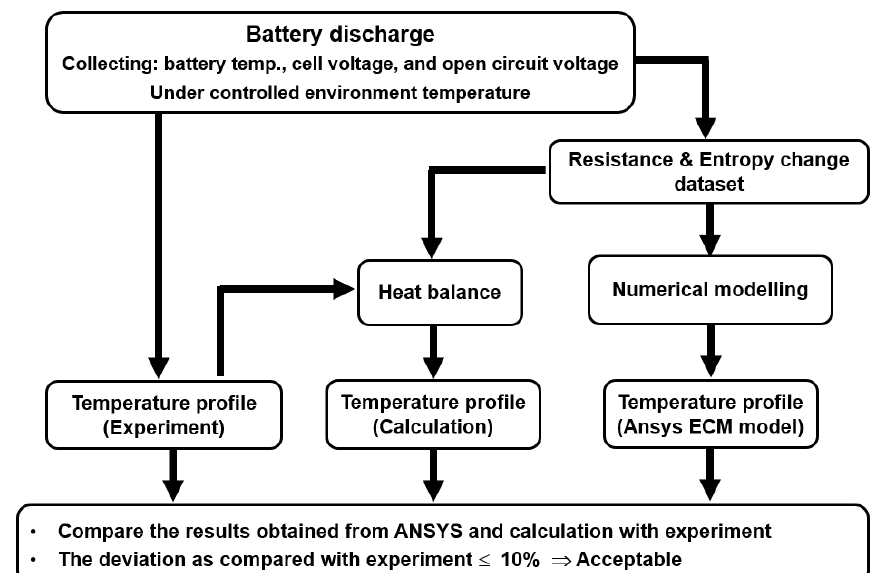
Figure 3. Diagram of methodology.